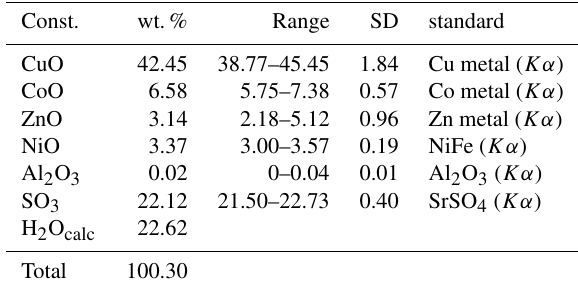
Table 1. Analytical results ( n = 9) for gobelinite from Cap Garonne. Const.